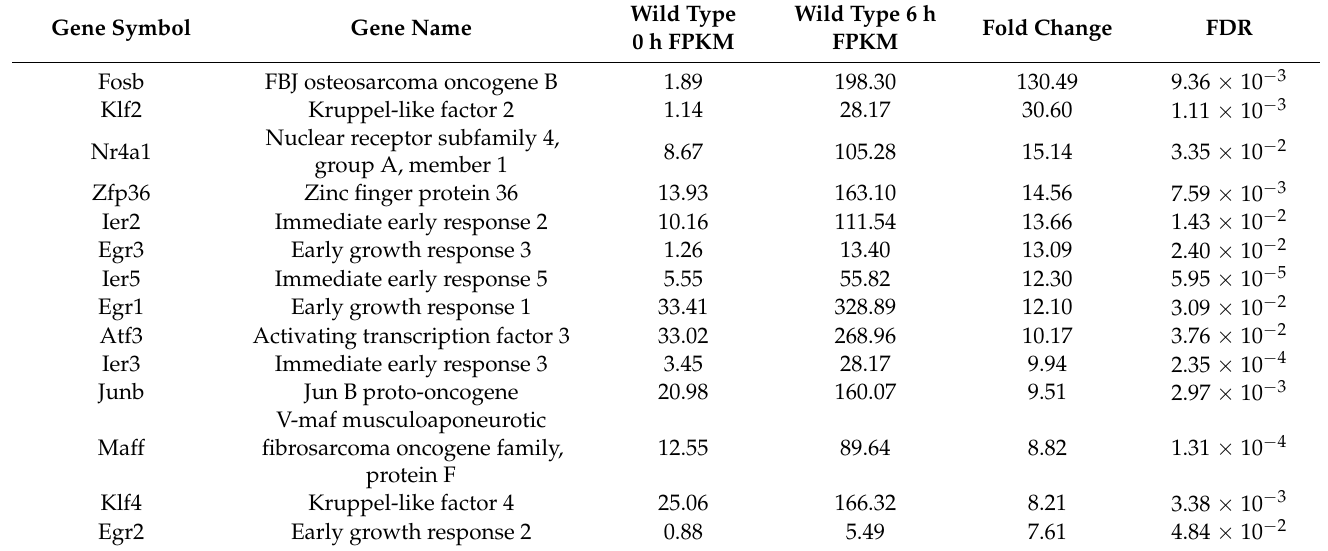
Table 3. IETFs differentially expressed in wildtype mouse LECs at 6 h